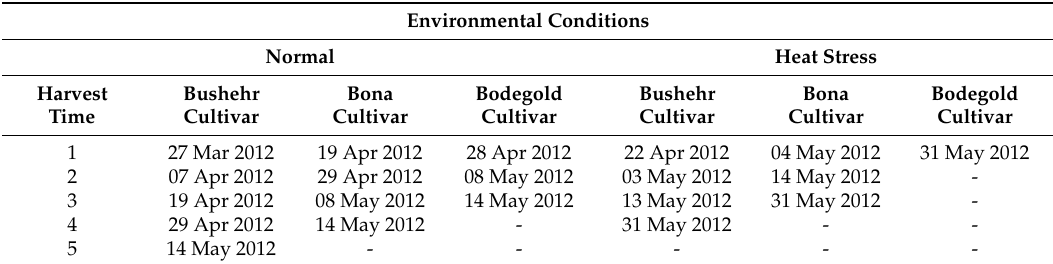
Table 6. Harvest times of chamomile cultivars under normal and heat stress